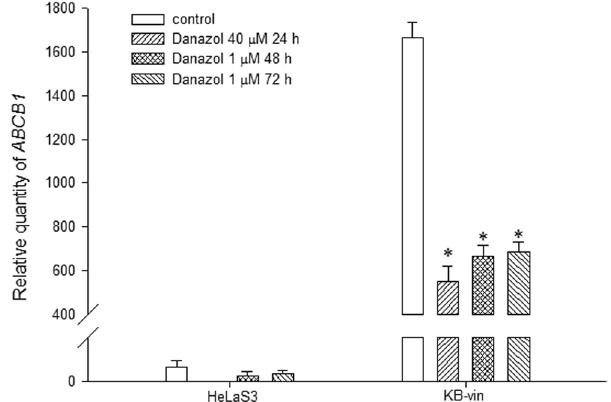
Figure 2. Results of ABCB1 gene expression analysis. HeLaS3 and KB/VIN were treated with danazol for 24, 48, and 72 hours. Total RNA was extracted and ABCB1 gene expression level of each sample was quantified by real-time PCR. The ABCB1 gene expression was significantly down-regulated by danazol treatment in KB/VIN cell line. Statistical differences were evaluated by ANOVA followed post hoc analysis (Tukey’s test). * Indicates p value < 0.05 compared with control group. Data presented as mean ± SE of at least three experiments, each in